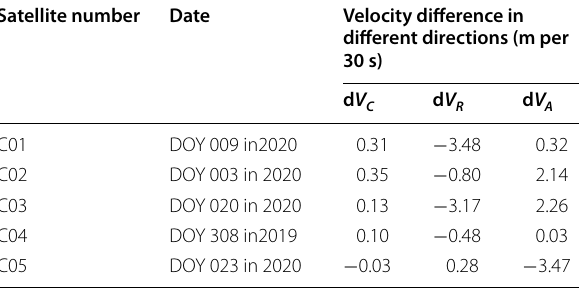
Table 2 The total velocity changes in the radial, along-track, and cross-track components Satellite